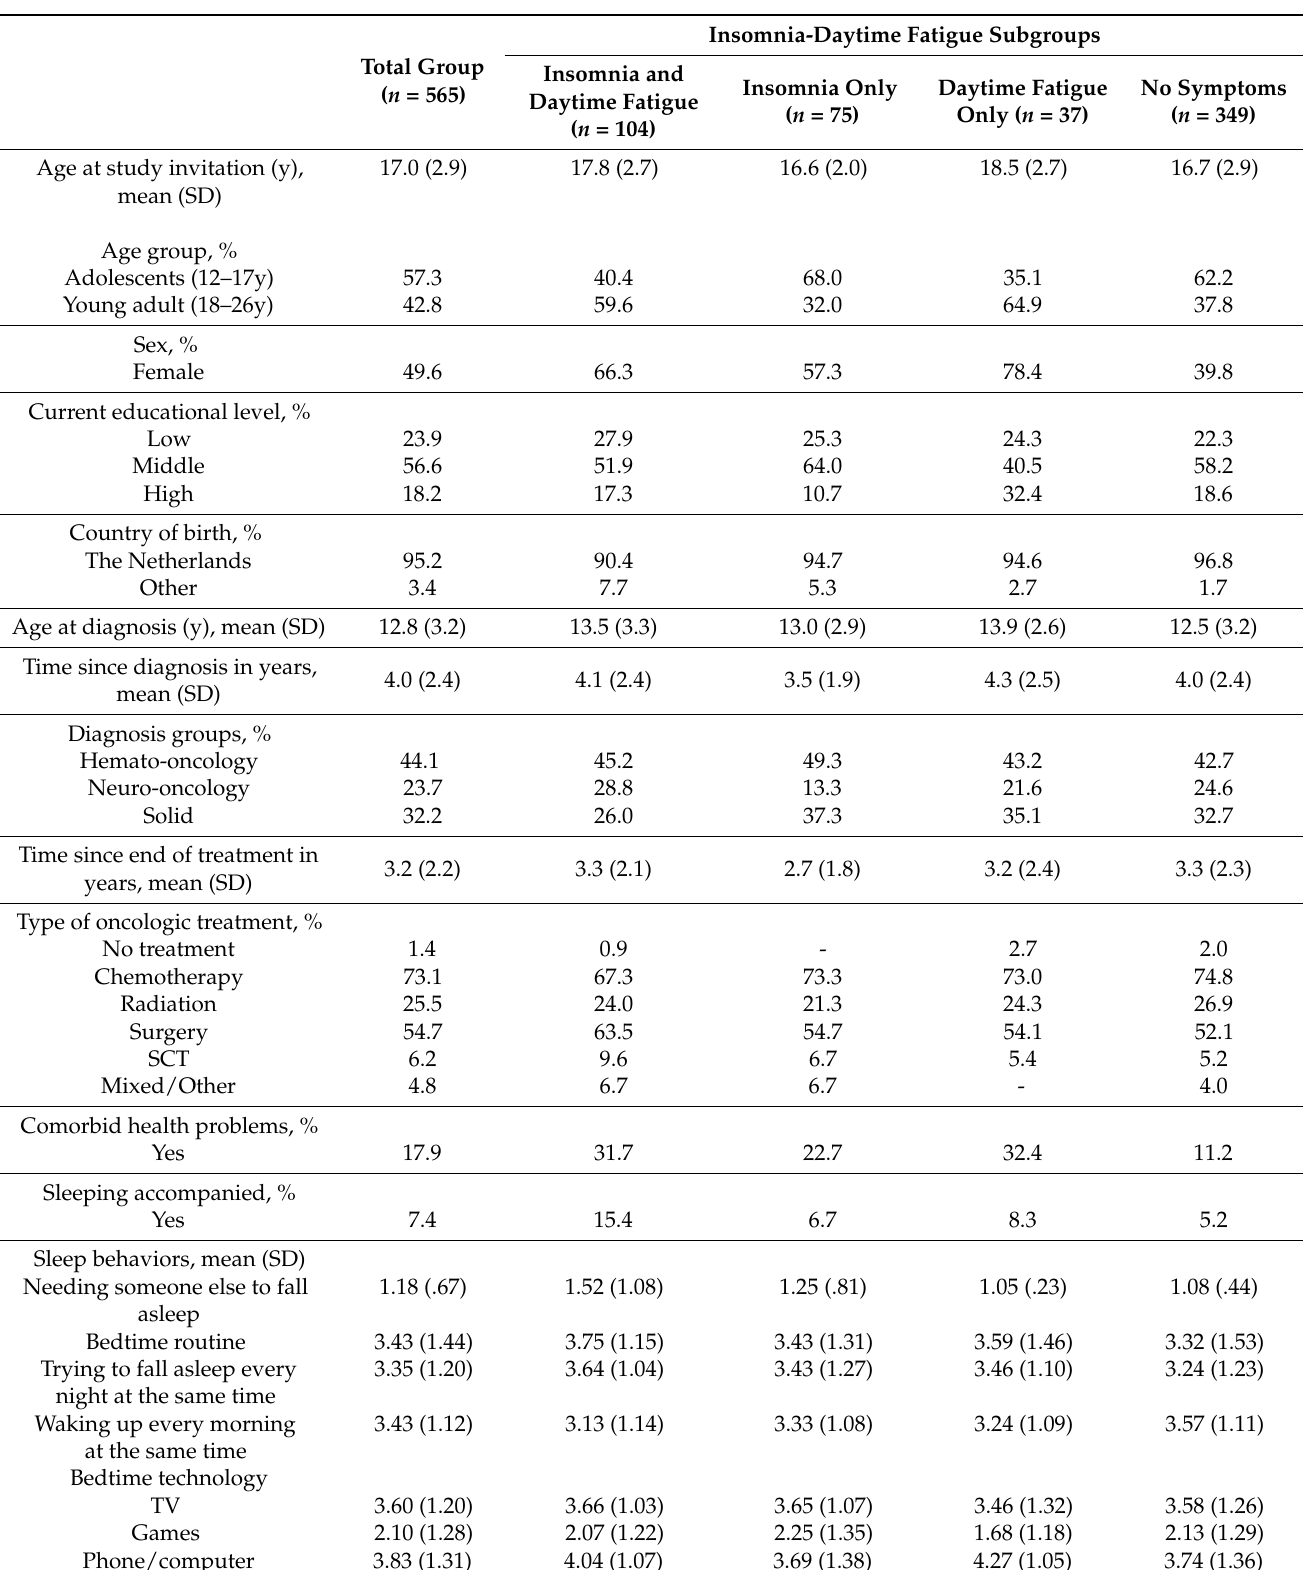
Table 1. Sample characteristics per total group and per insomnia–daytime fatigue